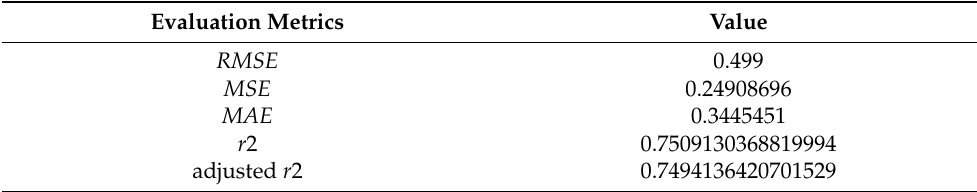
Table 3. Evaluation metrics for the linear regression